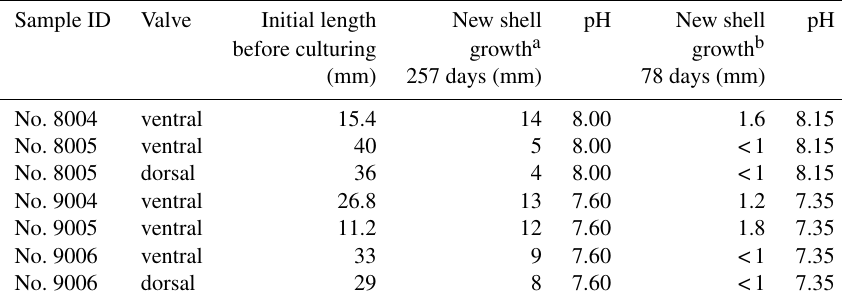
Table 4. Shell length of specimens of M. venosa before and during the culture.